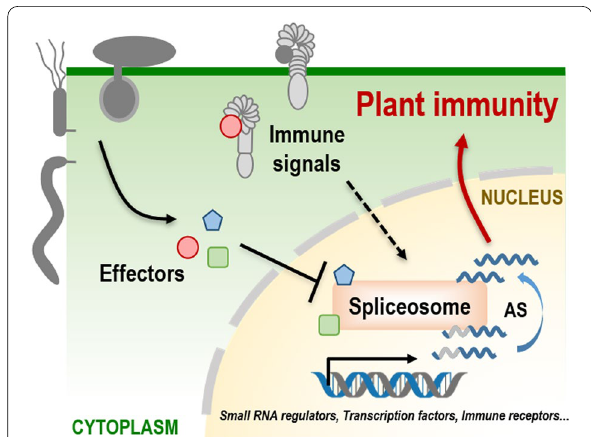
Fig. 1 The model of pathogen subverting plant alternative splicing (AS) process to promote infection. When recognizing the pathogen, plants selectively induce alternative splicing on pre-mRNA of immune-related genes, such as small RNA regulators, transcription factors and immune receptors, to activate plant immune